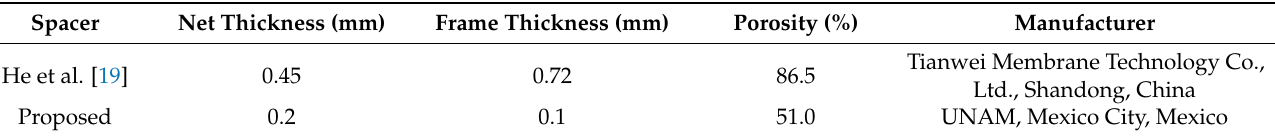
Table 5. Comparison between He et al. [19] and proposed